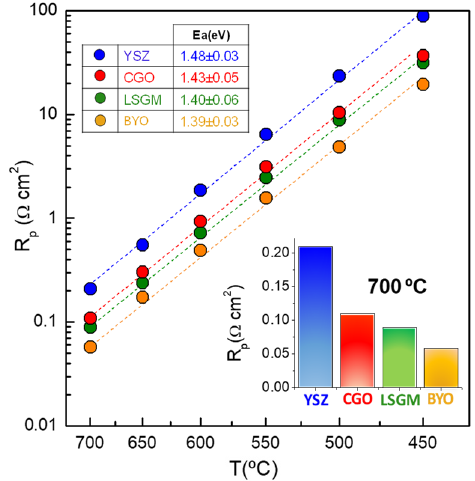
Figure 5. Overall polarization resistance of LSCF nanostructured electrodes deposited onto different electrolytes as a function of temperature. The inset figure compares the polarization resistance at 700 °C.